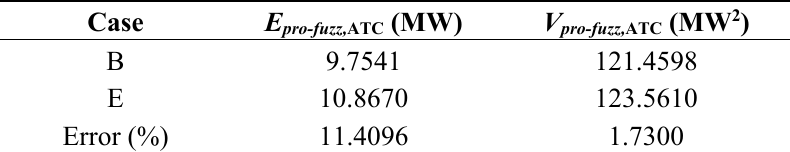
Table 3. The results of Case B and Case E.